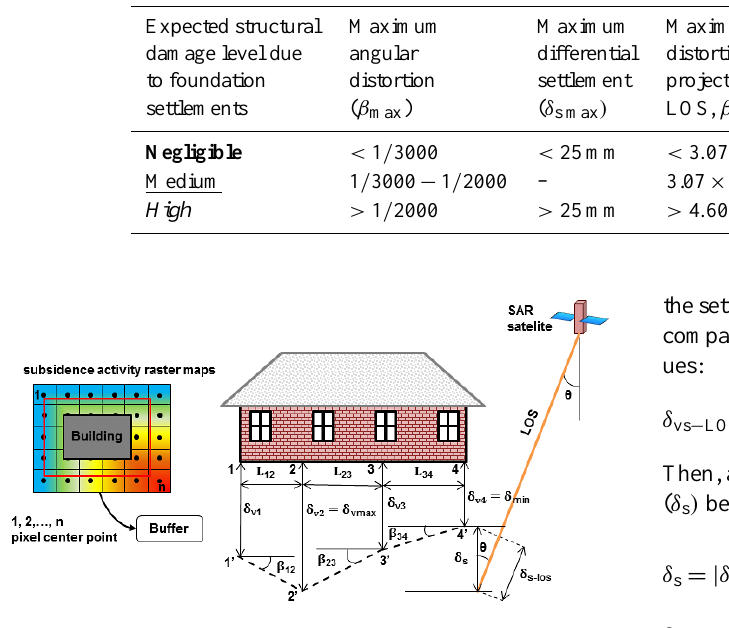
Table 1. Adopted SLS criterion for the performed analysis.